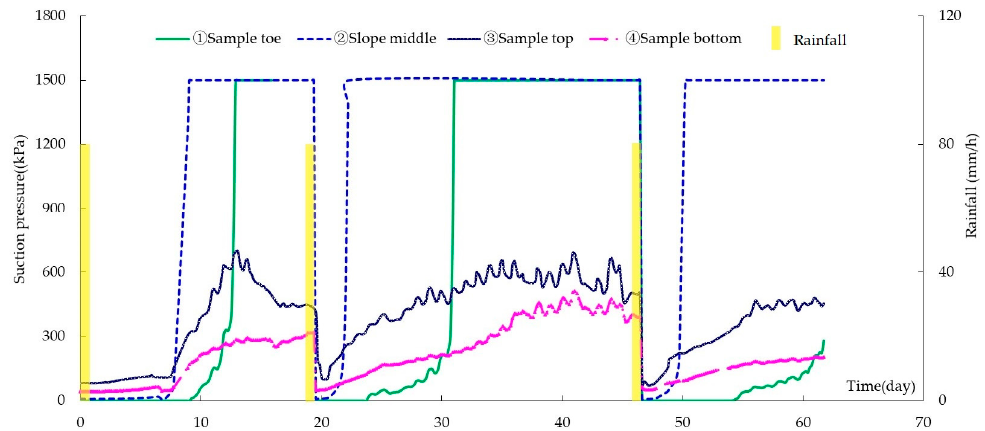
Figure 8. Suction pressure in various parts of the sample during three wet and dry cycles.